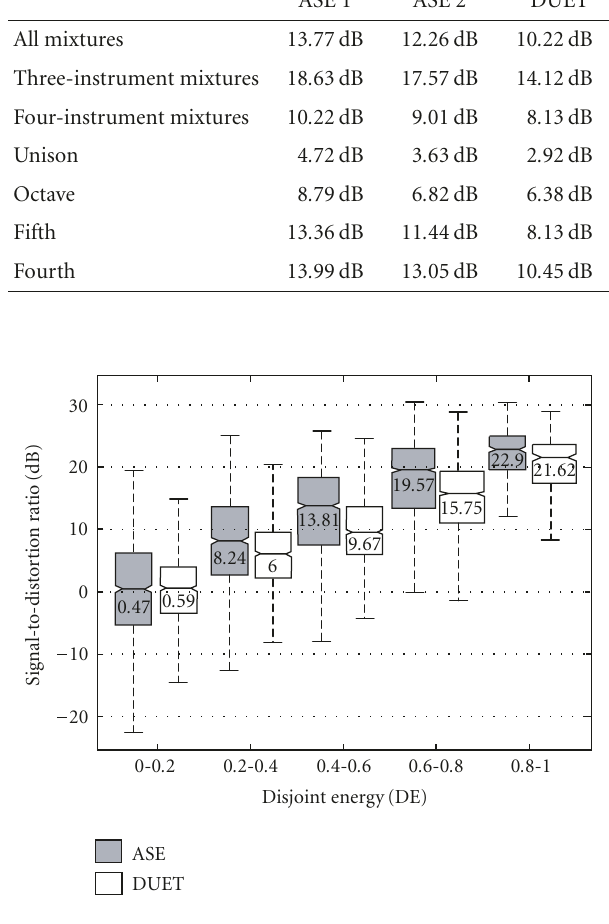
Figure 3: ASE 1 and DUET SDR performance over five groups of signals. Signals are grouped according to disjoint energy, DE . Me- dian performance is shown in the lower half of each box. Higher values are